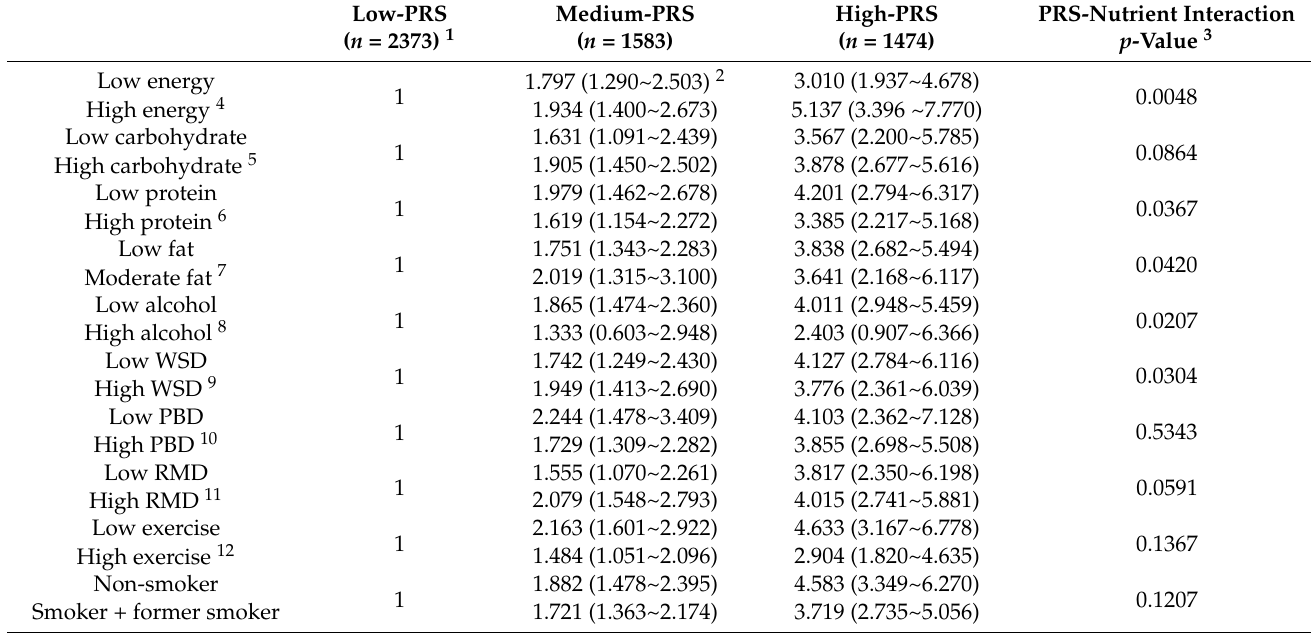
Table 5. Adjusted odds ratios for osteoarthritis risk by polygenetic risk scores of the 5-SNP best model (PRS) for gene–gene interaction after covariate adjustments according to lifestyle